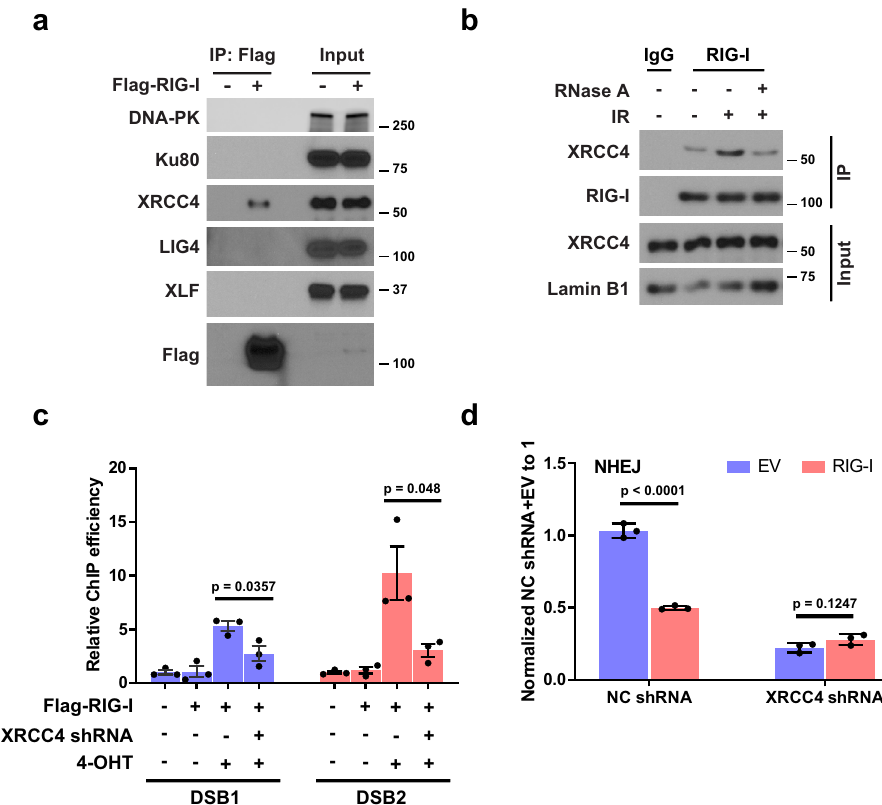
Fig. 2 XRCC4 is required for the recruitment of RIG-I to DSB sites. a HEK293T cells were transfected with empty vector or Flag-RIG-I. The cells were then lysed and immunoprecipitated with anti-Flag agarose beads. The beads were boiled and probed with indicated antibodies. b A549 cells were treated with IR (10 Gy, 1 – 2 h). Cells were lysed, and nuclear fractions were immunoprecipitated with anti-RIG-I antibody. The beads were treated with RNase A, boiled and blotted with indicated antibodies. c Control and XRCC4 knockdown ER-AsiSI U2OS cells were transfected with Flag-RIG-I, and then treated with 4-OHT to induce DSBs. Flag-RIG-I accumulation at DNA damage sites generated by AsiSI was detected by ChIP-qPCR. Data are presented as mean values ± SEM from three independent experiments. P values are determined by unpaired two-sided t -test. d Control and XRCC4 knockdown HEK293T cells overexpressing RIG-I were transfected with NHEJ reporter, and then cells were harvested for the NHEJ assay. Data are presented as mean values± SEM from three independent experiments. P values are determined by unpaired two-sided t